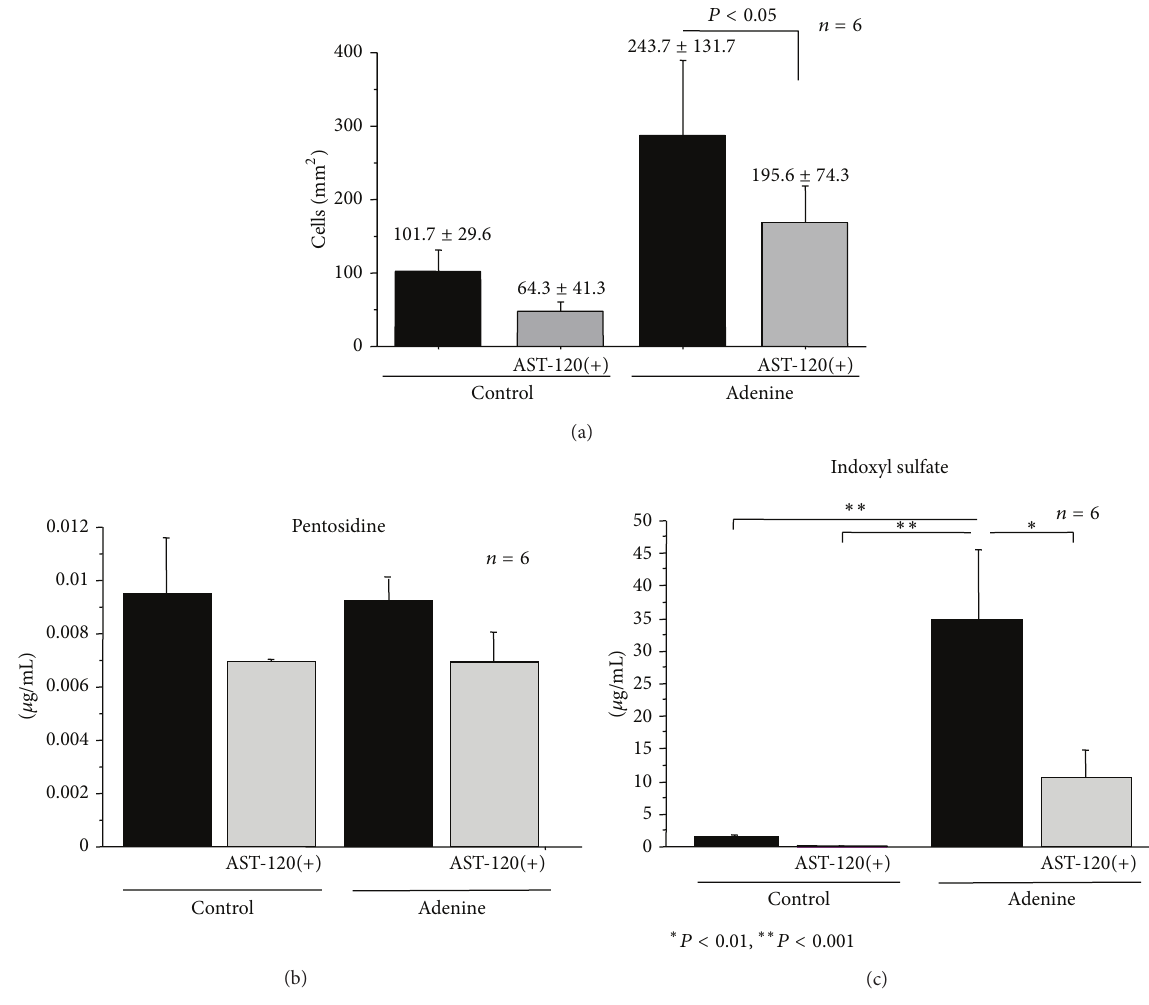
Figure 2: (a) Monocyte adhesion to the endothelium assessed by NEMOes, (b) levels of pentosidine in sera, and (c) levels of indoxyl sulfate in sera ∗ 𝑃 < 0.01 and ∗∗ 𝑃 < 0.001